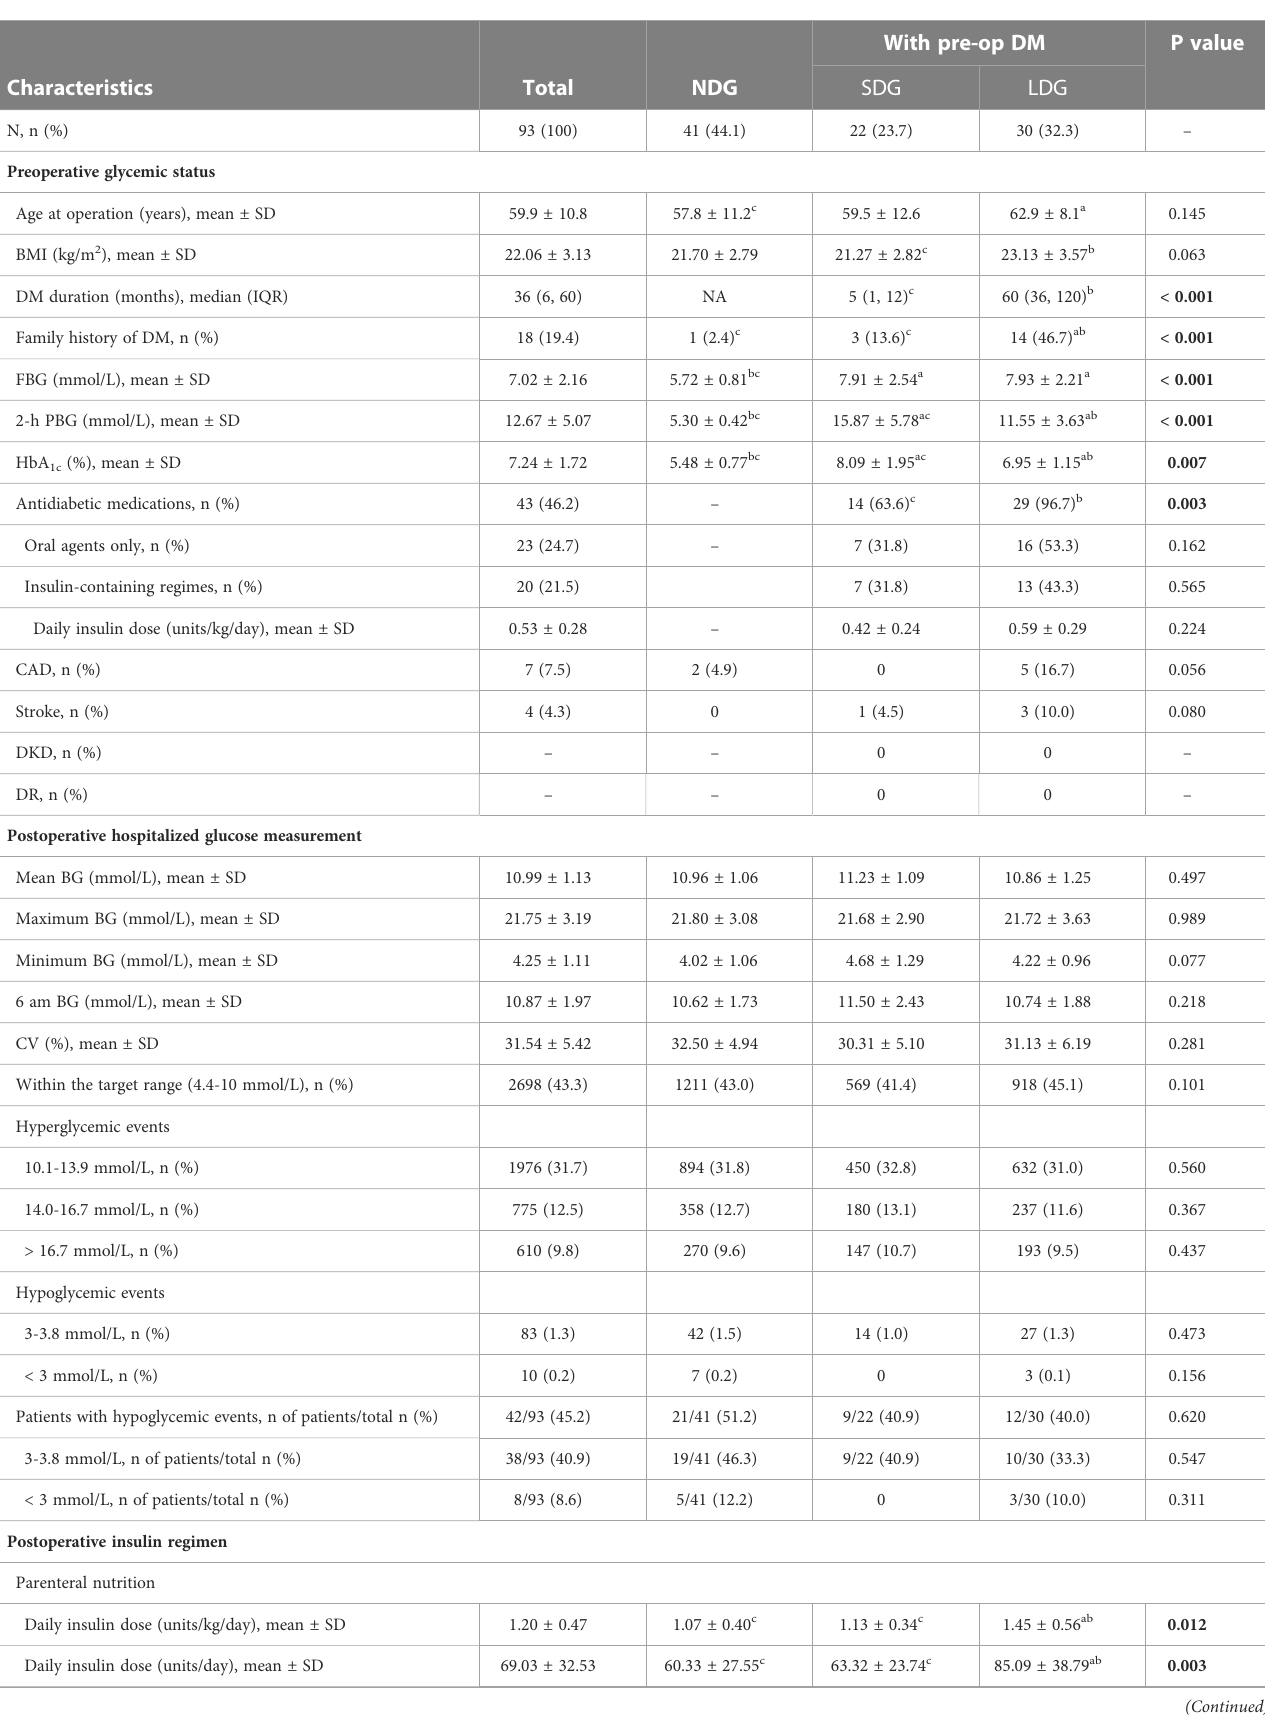
TABLE 2 Perioperative glucose measurements and insulin regimens in patients underwent total pancreatectomy.